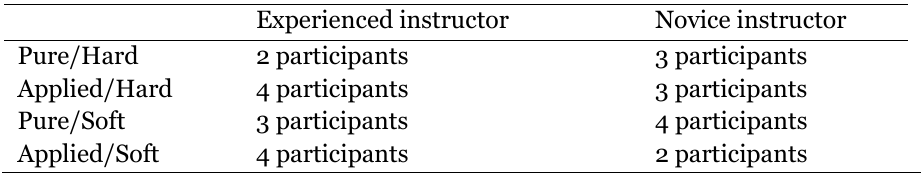
Table 1 Participant Distribution Matrix Experienced instructor Novice instructor Pure/Hard 2 participants 3 participants Applied/Hard Pure/Soft Applied/Soft Study